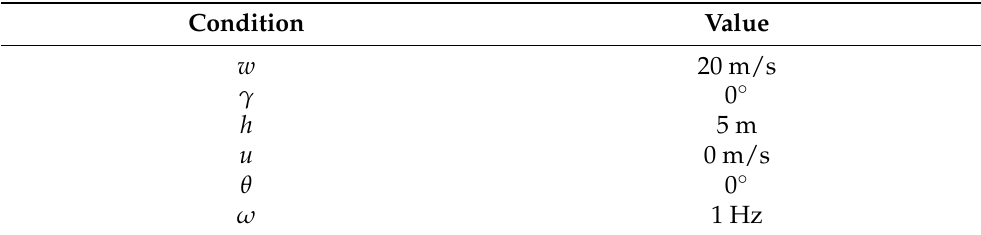
Table 2. Selected detrimental conditions. 0 degrees refers to tail